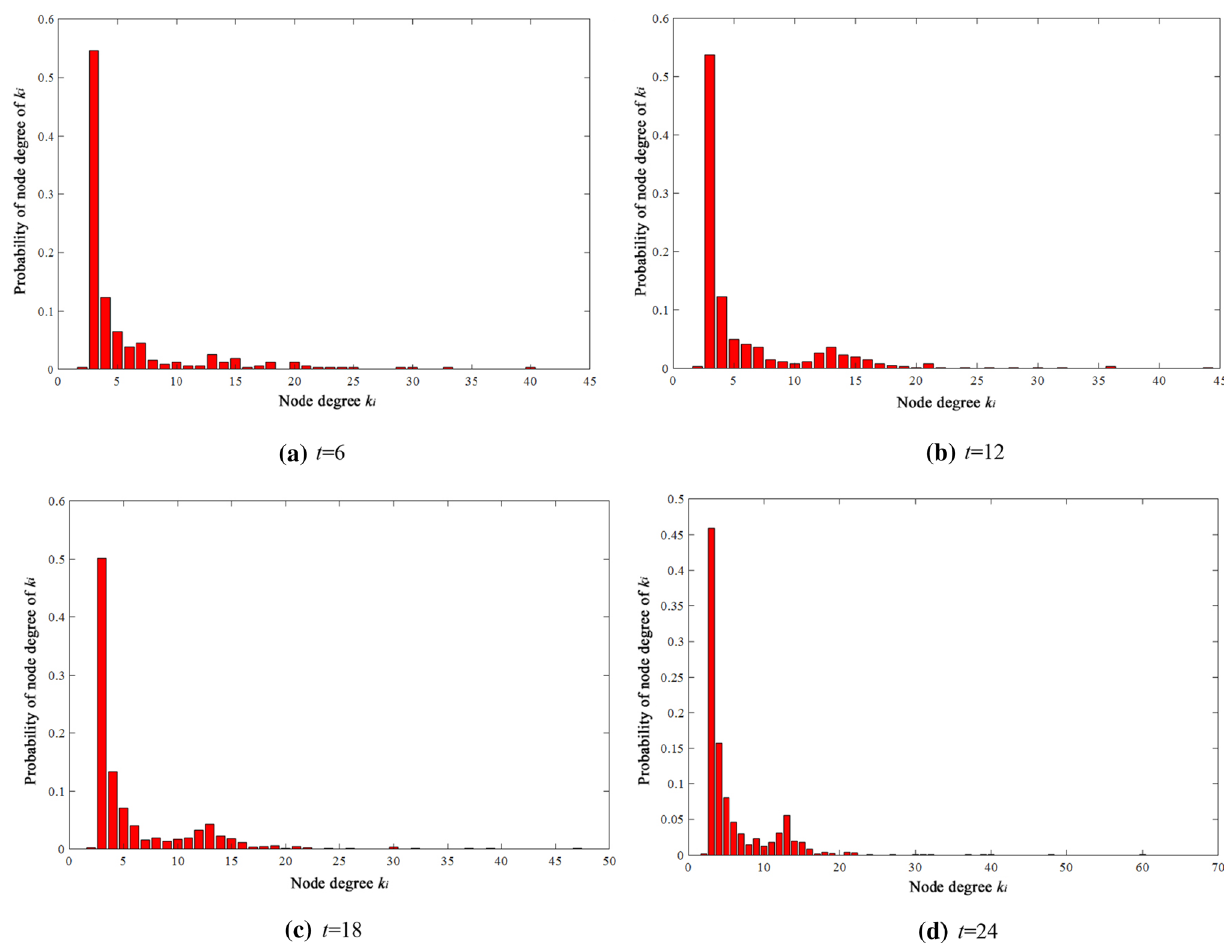
Fig. 10 Probability distribution of node degree of the regional logistics